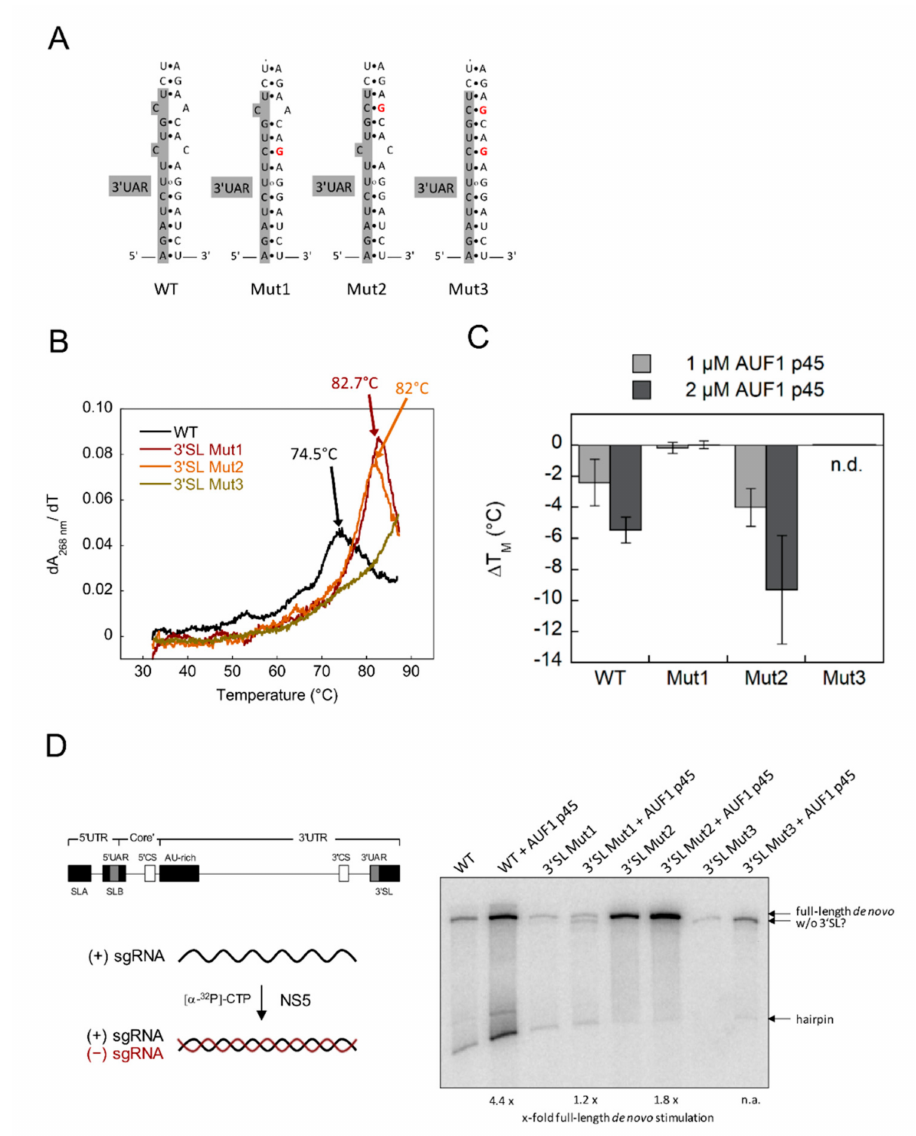
Figure 2. Increasing stability of the WNV 3 (cid:48) SL correlates with decreasing RNA chaperone activity of AUF1 p45. ( A ) Sequence and secondary structure of the bottom part of the WNV 3 (cid:48) SL and mutants. Introduced mutations are shown in red. The 3 (cid:48) UAR cyclization sequence is shown in grey. ( B ) First derivatives of thermal denaturation experiments of the 3 (cid:48) SL trunc wild-type and mutant RNAs. Melting temperatures are indicated with arrows. ( C ) Change of melting temperatures of thermal denaturation experimentsofthe3 (cid:48) SL trunc wild-typeandmutantRNAsinthepresenceofAUF1p45. n.d., notdefinable. Average results and standard deviations ( n = 3) are shown. ( D ) Schematic drawing of the WNV sgRNA and experimental outline of the replicase assay. The RNA consists of the 5 (cid:48) - and 3 (cid:48) UTR and a part of the core coding sequence. It contains the 5 (cid:48) SLA, the 3 (cid:48) SL, all cyclization elements, and the AU-rich element in the upstream portion of the 3 (cid:48) UTR (left). WNV sgRNAs that contained the wild-type or mutant 3 (cid:48) SL were tested in the replicase assay in the absence or presence of AUF1 p45. The products were analyzed by denaturing PAGE and phosphor imaging. One representative experiment is shown (right). Levels of stimulation of full-length de novo product relative to the control (absence of AUF1 p45) are given below. n.a., not